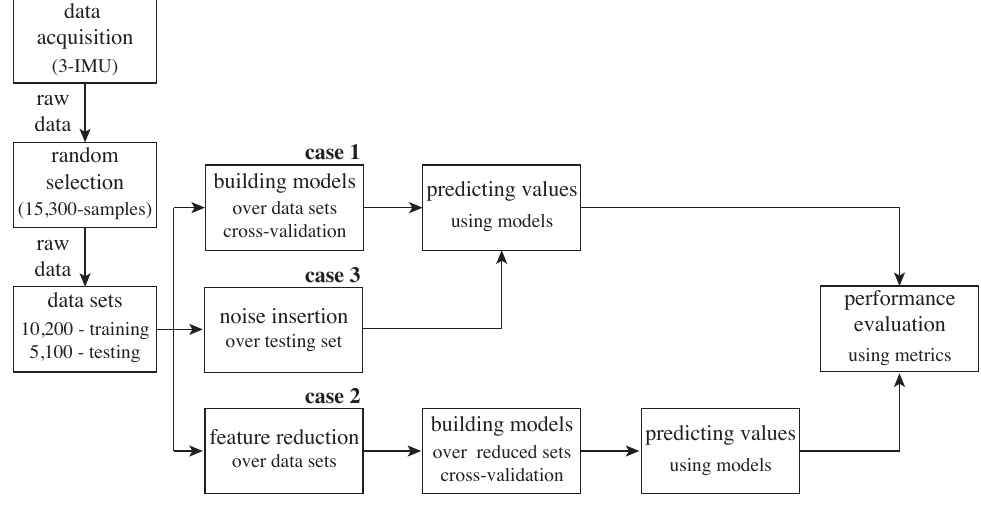
Figure 5. Methodology of experimentation.